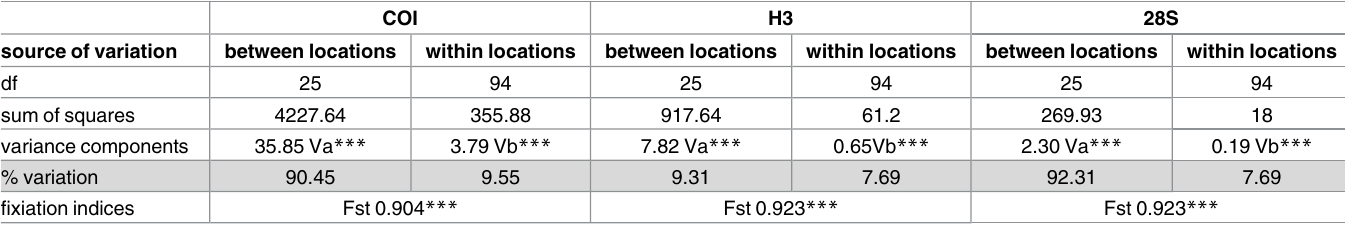
Table 4. Analysis of molecular variance(AMOVA) among and within sampling locations of the Parisotoma notabilis sampled across Europe, based on sequence varianceof three genes. COI H3 source of variation between locations within locations between locations within locations between locations within